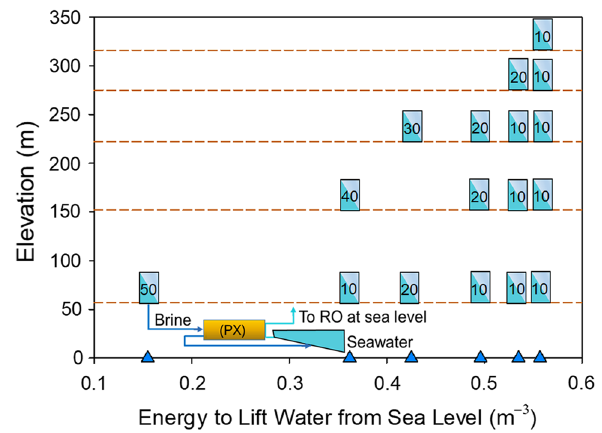
Fig. 5 Different arrangements of the RO stages, ranging from five stages to one at heights of 316, 275, 222, 152, and 57 m above sea level. The recovery at each RO stage is indicated. The total recovery in every shown arrangement adds to 50%. The energy-saving for the multistage elevation-distributed RO compared to RO at sea level fol- lowed by lifting the desalinated water is indicated on the x-axis for each arrangement and is 0.557, 0.535, 0.496, 0.425, 0.362, and 0.155 kWh/m 3 from right to left. The energy stored in the brine from the last stage can be transferred to seawater using a PX energy recovery device for an additional RO stage at sea